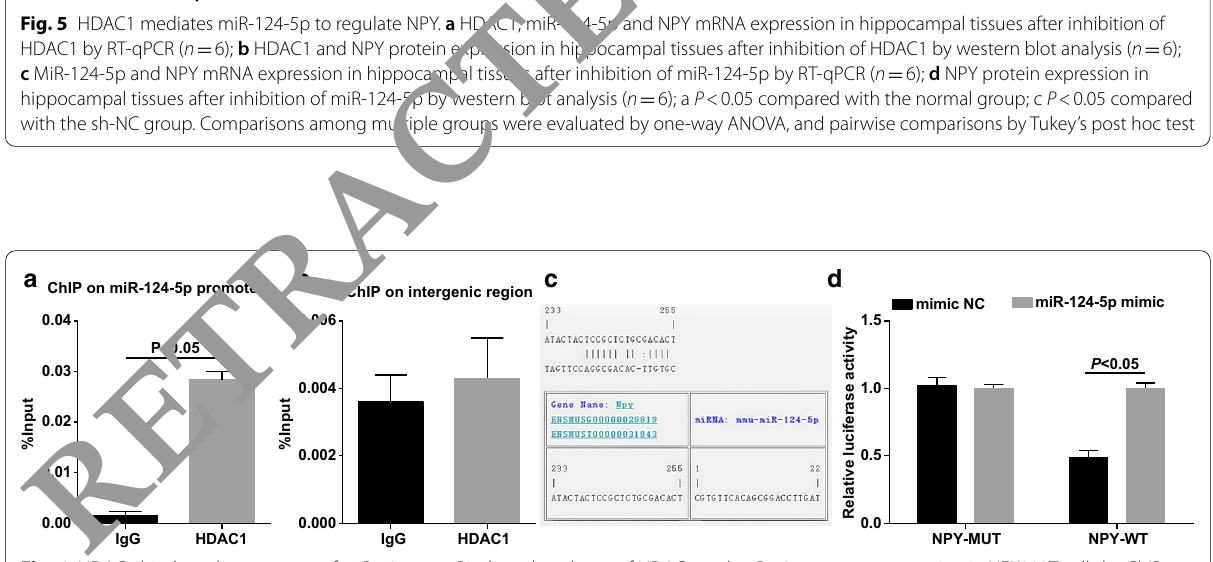
3); c MiR-124-5p and NPY =